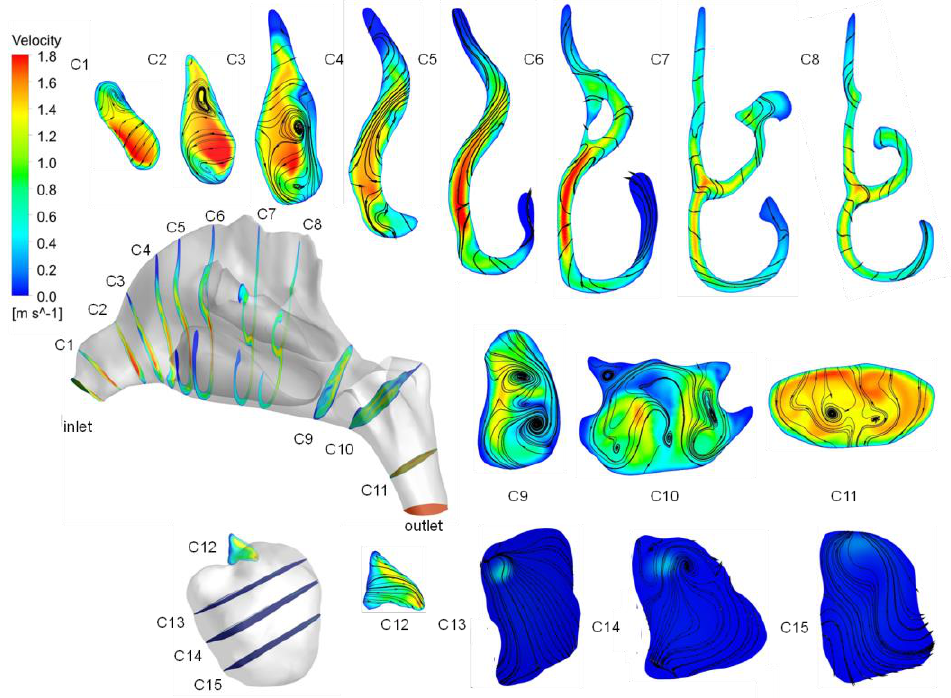
Figure 3. Axial flow and secondary flow model diagrams for each characteristic cross-section under the 15 L/min inspiratory condition in the standing position.